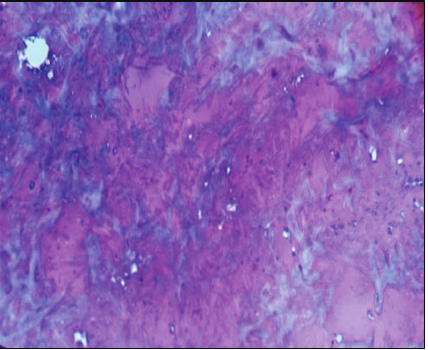
Figure 8: Section showing islands of basophilic mature cartilagi- nous tissue (H&E